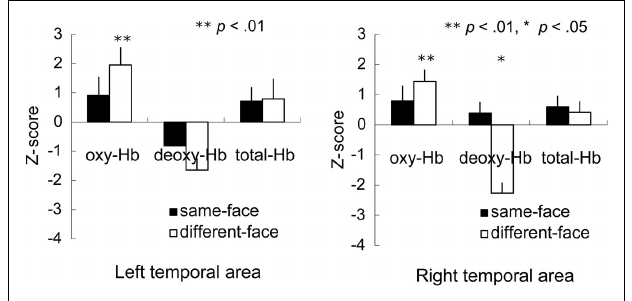
FIGURE 4 | Mean Z -score from 3 to 7s of the trial in the bilateral temporal area in the Experiment 1. The vertical line in the graphs represents 1 SE. In the different-face condition (white bar), the concentration of oxy-Hb in both the right and left temporal areas increased significantly compared to the chance level of 0 ( ∗∗ p < 0.01, ∗ p < 0.05).